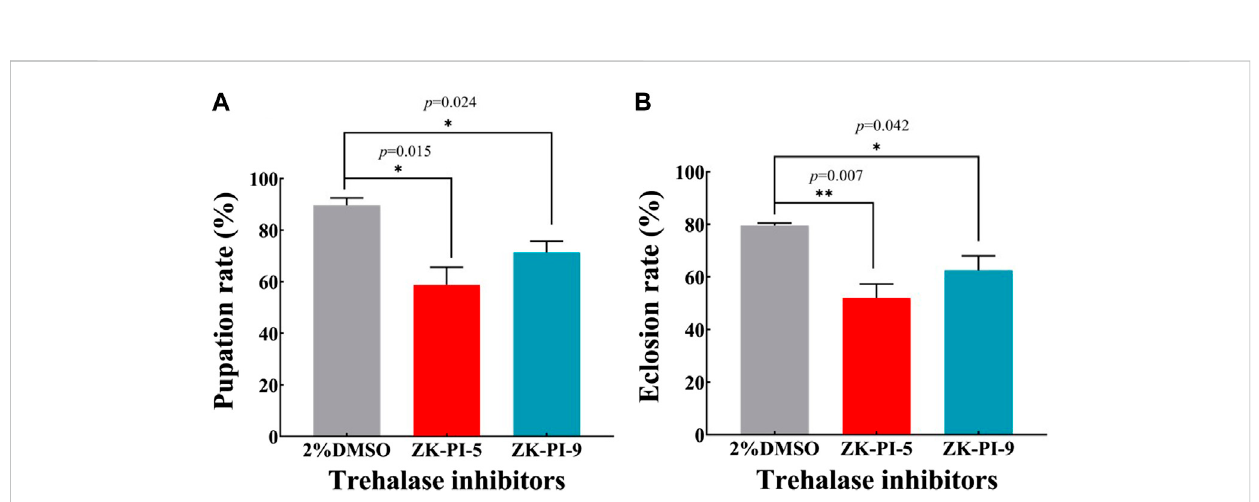
FIGURE 6 The pupation (A) and eclosion rates (B) of S. frugiderda after injection of two trehalase inhibitors. The changes in pupation and eclosion rates during the development of S. frugiderda after injection of trehalase inhibitors were recorded compared with the control group. Pupation rate = (pupal number/ 6thinstarlarvalnumber)*100%;Eclosionrate=(numberofadults/pupalnumber)*100%. N =150pertreatment.Valuesarepresentedasthemeans±SE. * p < 0.05 denotes signi fi cant differences. ** p < 0.01 denotes extremely signi fi cant differences (independent-samples t